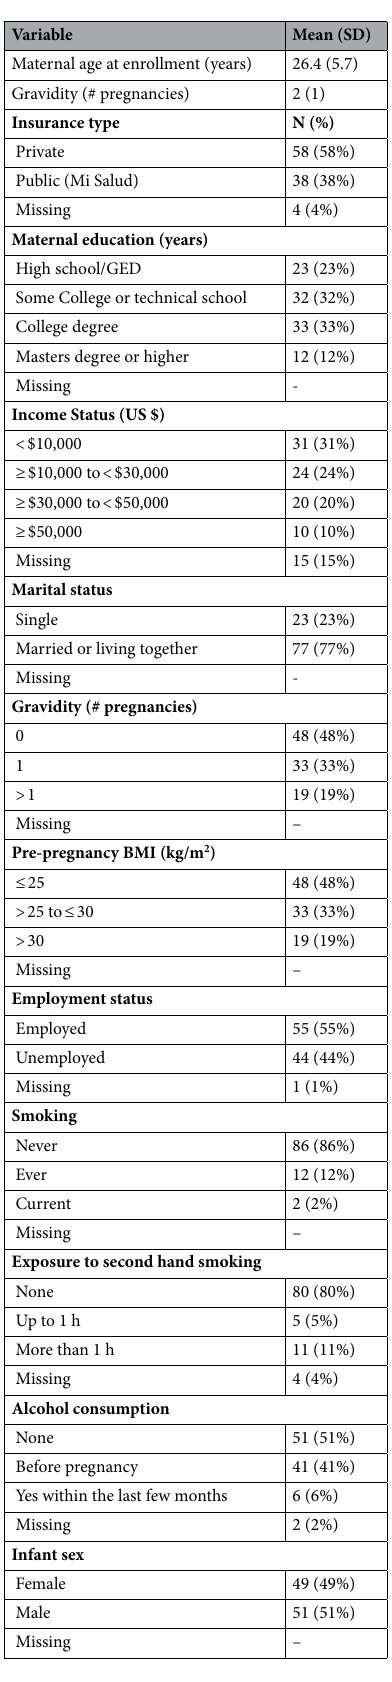
Table 1. Demographic characteristics of study participants recruited between 24 and 28 weeks gestation from the Puerto Rico Testsite for Exploring Contamination Threats (PROTECT) cohort (n =